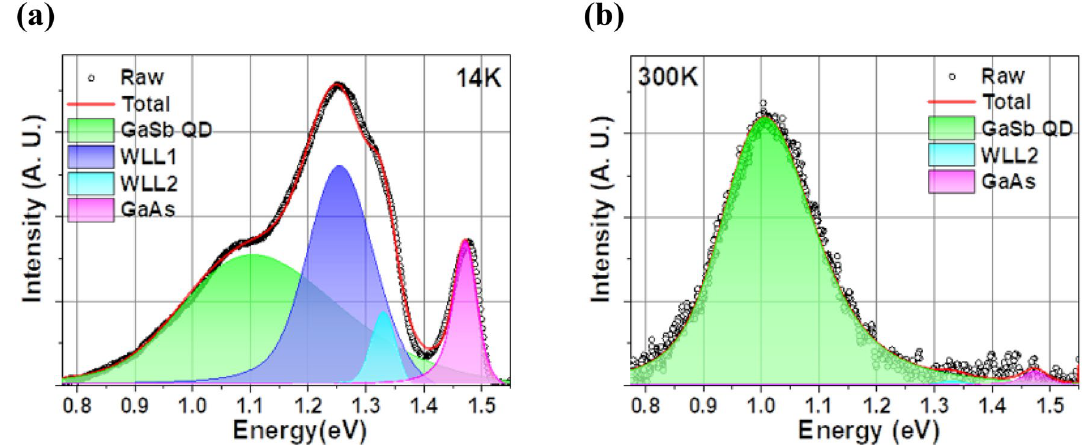
Figure 6. Fitting data of linear-scale PL spectra at ( a ) 14 K and ( b ) 300 K for calculating E-IQE based on comparing two areas of GaSb